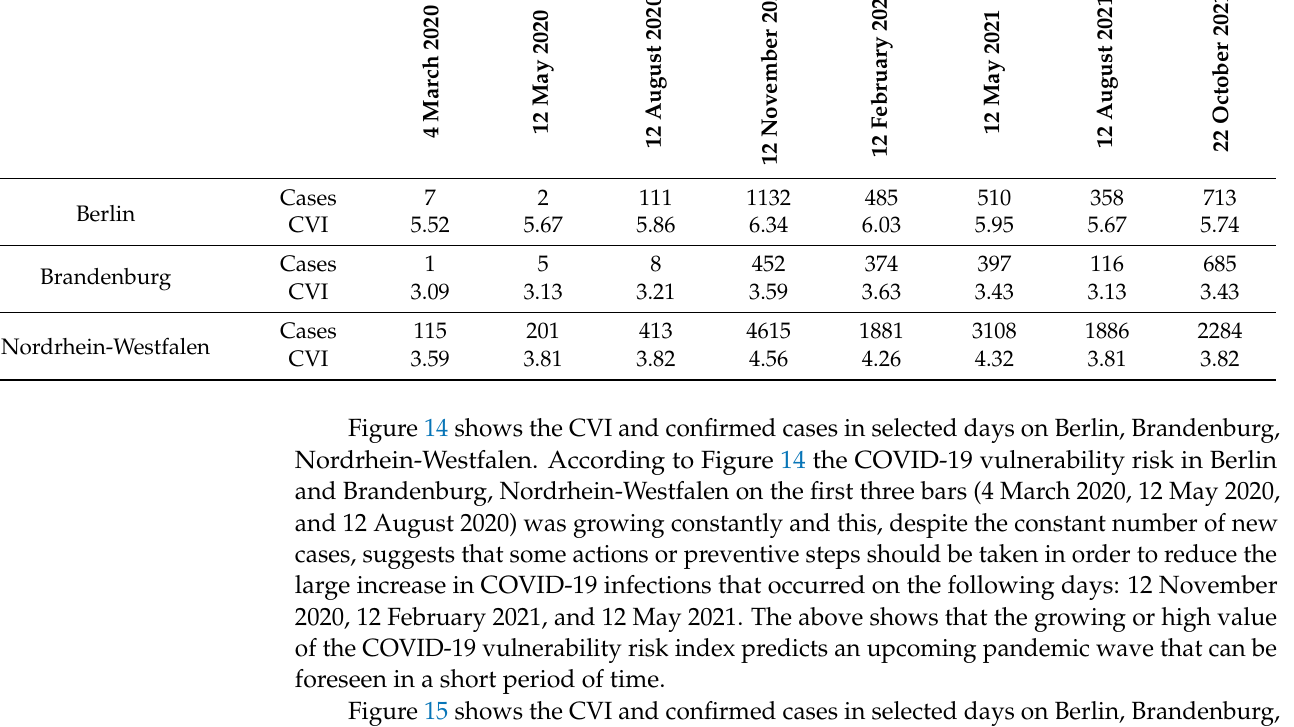
Table 6. CVI and new COVID-19 Cases in time for Berlin, Brandenburg, Nordrhein-Westfalen.